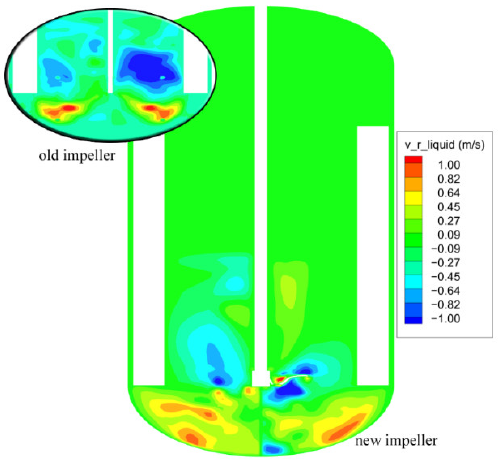
Figure 7. Radial velocity distribution of liquid phase, old impeller vs. new impeller.